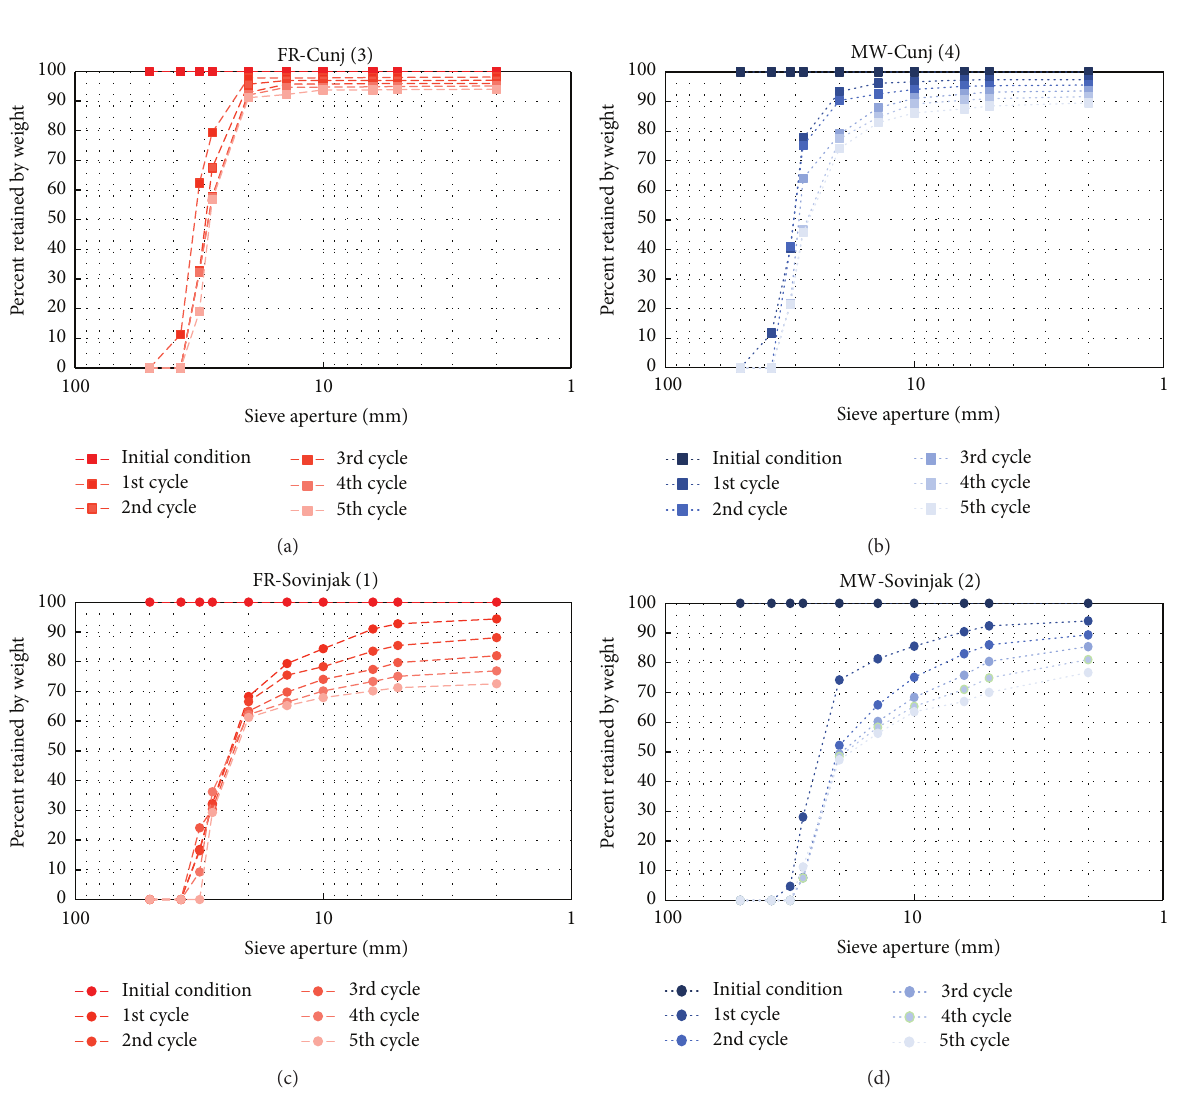
Figure 8: Fragment size distribution curves of the retained weight for the siltstone samples of weathering grades (a) I (FR) (3) and (b) III (MW) (4) from a flysch outcrop near Cunj Village and samples of weathering grades (c) I (FR) (1) and (d) III (MW) (2) from a flysch outcrop near Sovinjak